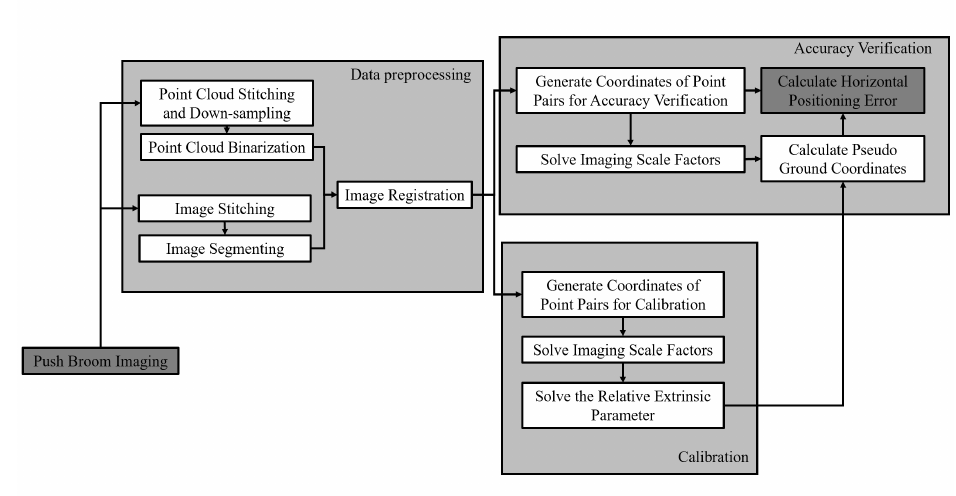
Figure 8. Flowchart of simulation experiment.